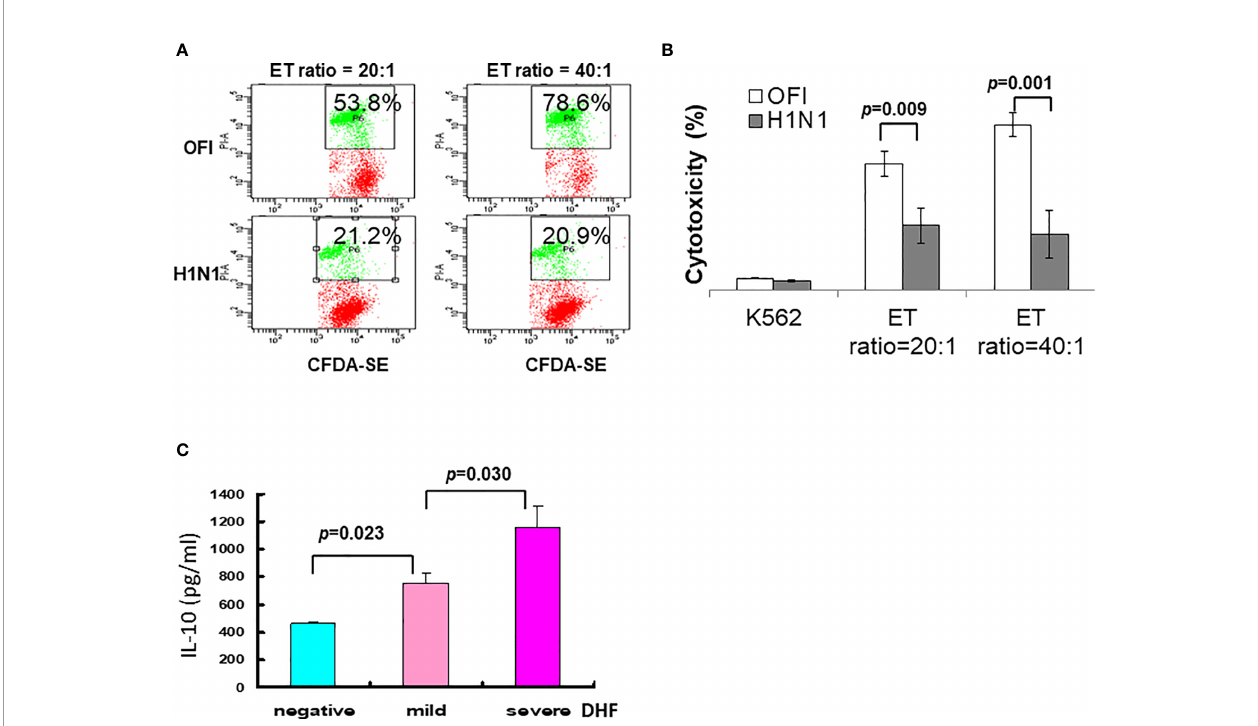
FIGURE 4 | Immune alteration of in fl uenza A (H1N1) 2009 and dengue infection. (A) Depressed NK cell activity in in fl uenza A (H1N1) 2009 infection. Employing K562 cells labeled with CFDA dye, the cell cytotoxicity was detected by propidium iodide (PI). (B) The NK cell cytotoxic activities in patients with in fl uenza A (H1N1) 2009 infection were signi fi cantly depressed either in effector-target (ET) ratio at 20:1 or 40:1 in comparison to those in patients with other febrile illness (OFI). (C) A signi fi cant association of IL-10 levels among dengue infections with mild or severe DHF. In a dengue outbreak, a cohort of patients with dengue fever, and